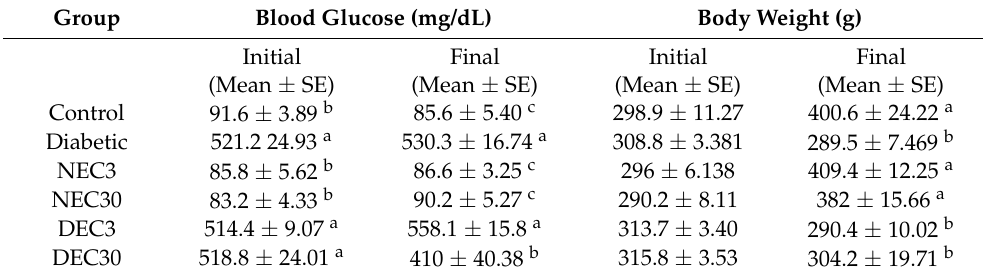
Table 4. Effect of the hexanic extract of E. carlinae inflorescences on body weight and blood glucose.